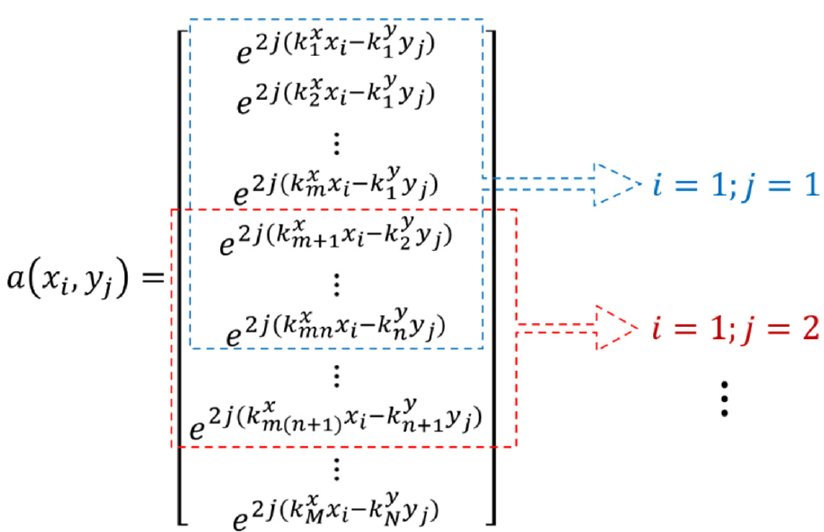
Figure 6. Steering vectors of length mn are taken out of the total vector length MN for computation of each pixel.